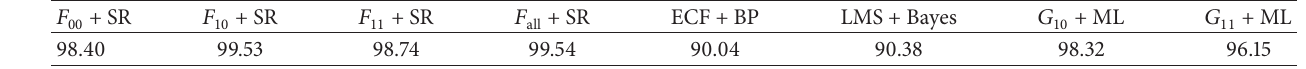
Table 3: Classification accuracy rates obtained by different algorithms (%).